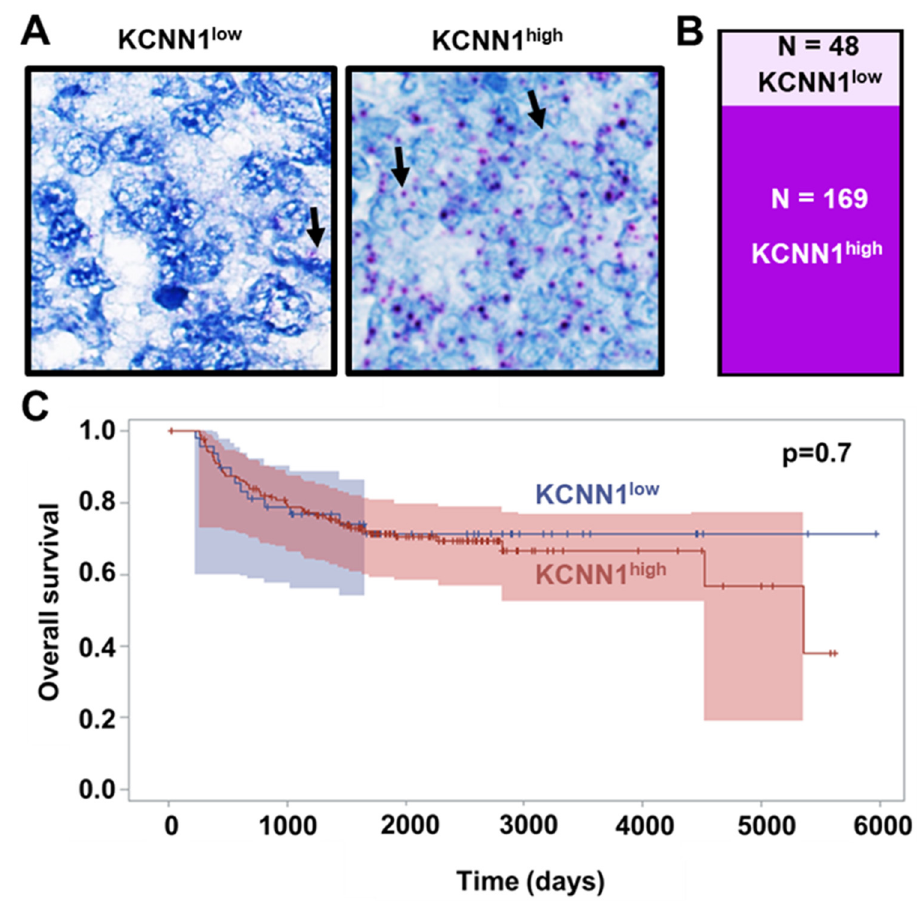
Figure 4. KCNN1 expression does not correlate with overall survival of Ewing sarcoma patients. ( A ) Representative RNAish brightfield image from EwS tissue microarrays. Black arrows pointing at purple dots indicate KCNN1 RNAish signal. For further analysis, we differentiated between KCNN1 low (left) and KCNN1 high (right) TMA samples. ( B ) Slice plot shows the relative amount of KCNN1 low KCNN1 high TMA sections in the cohorts ( C ) Kaplan–Meyer curve indicating the overall survival of KCNN1 low (blue) versus KCNN1 high (red) EwS patients in respect to the time after diagnosis. Survival functions between the groups were analyzed by a log-rank test. Fischer’s exact test was used to calculate p-values Shaded areas indicate 95% CI.